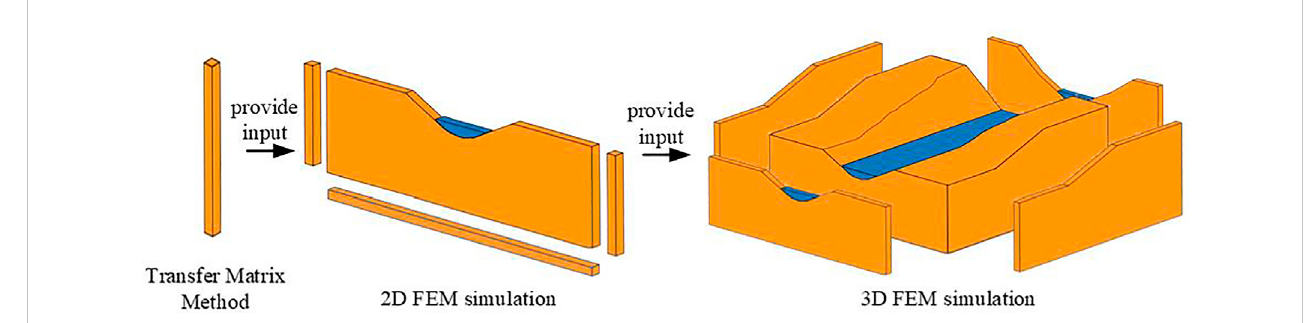
FIGURE 3 Flow chart for simulating wave propagation in 3D model with irregular boundary (Reproduced from fi gure 4.2 of Lokke (2019) with modi fi cation).